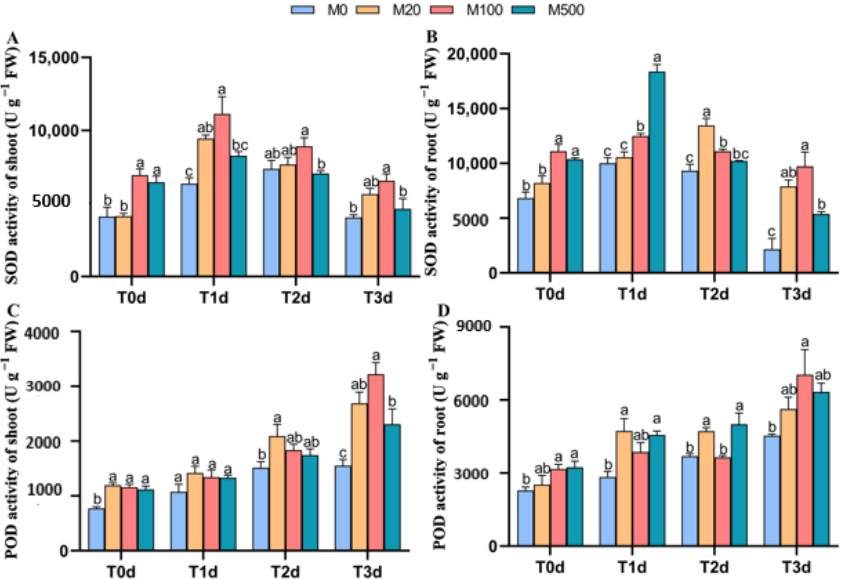
Figure 3. Effects of melatonin and flooding stress on SOD activity of shoots ( A ), SOD activity of roots ( B ), POD activity of shoots ( C ), and POD activity of roots ( D ). Different letters represent statistically significant differences ( p < 0.05).